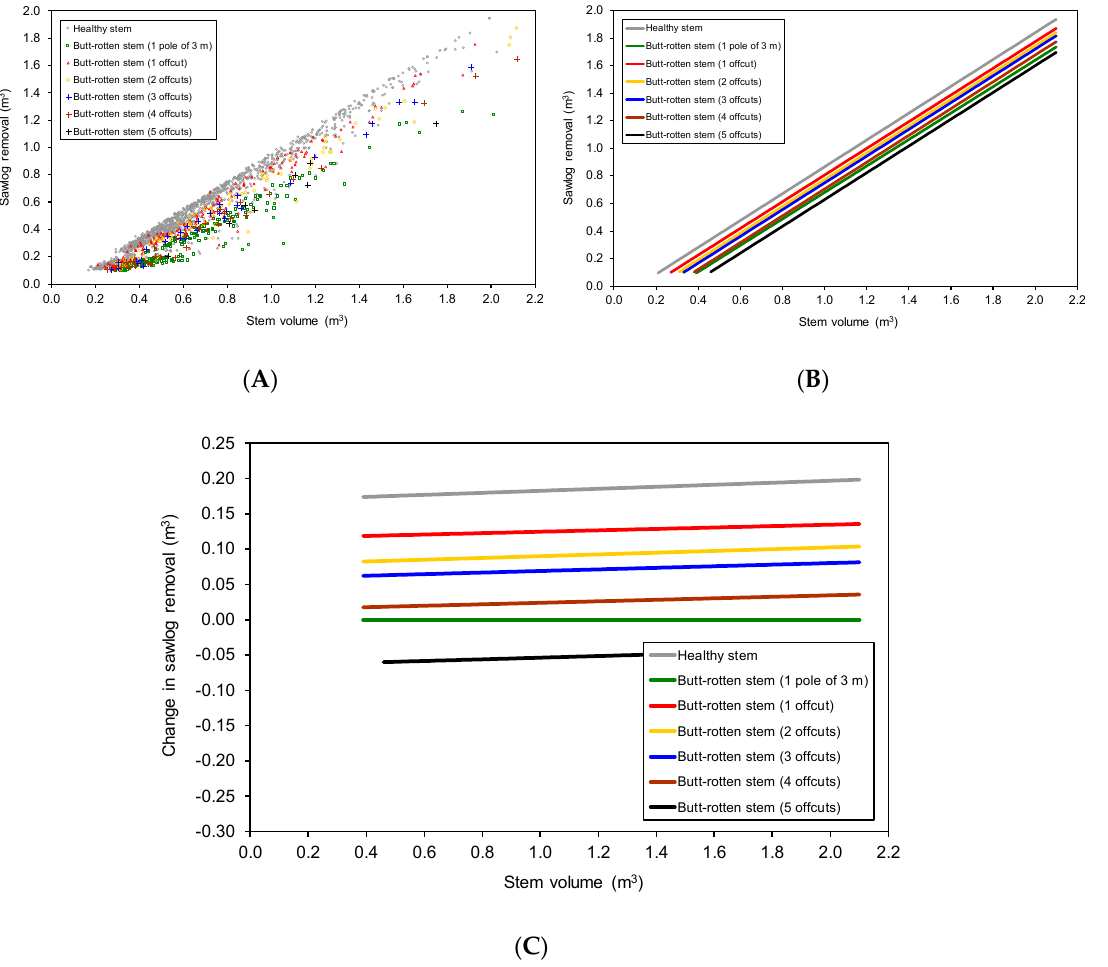
Figure 5. Sawlog removal observations ( A ), calculated sawlog removal lines ( B ) (Table 6), and change in sawlog removals by cross-cutting practice ( C ) compared to cross-cutting practice two (Zero level = cutting of one pole of 3 m) as a function of the stem volume. Table 6. Regression models for the sawlog removal by cross-cutting practice.